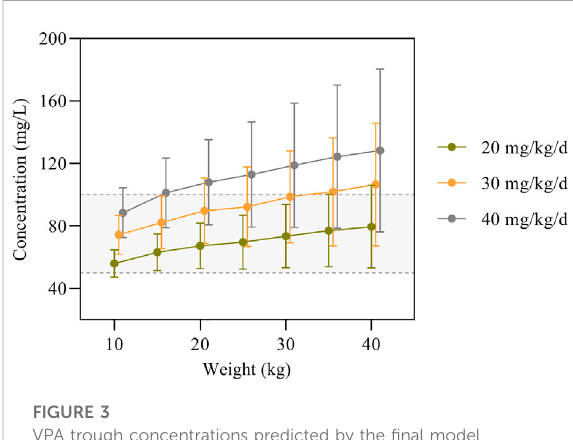
FIGURE 3 VPA trough concentrations predicted by the fi nal model based on dose and body weight. The concentrations are shown as means with error bars representing standard deviations from the mean. The semitransparent grey fi eld delimited by dashed lines represents the target therapeutic range (50 – 100